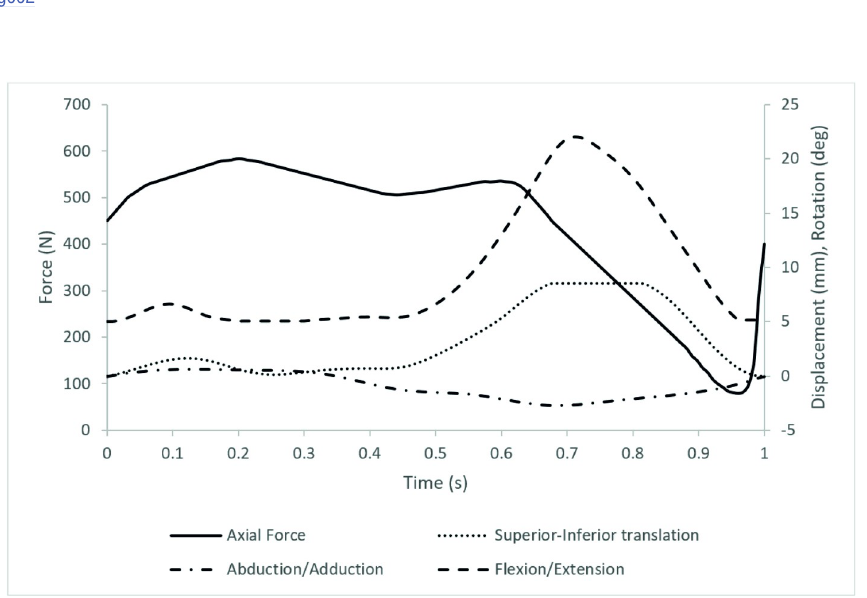
Fig 3. The simulation input profiles showing axial force (N), superior-inferior translation (mm), abduction/ adduction (deg) and flexion/extension (deg). Medial-Lateral translation was passive and Internal/External rotation constrained using